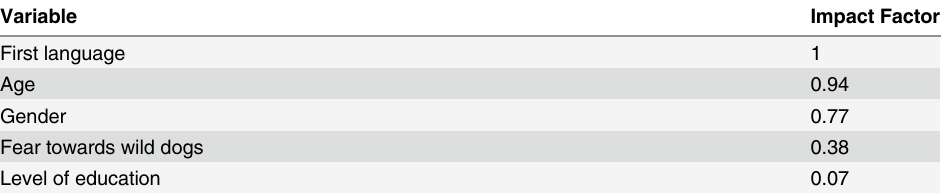
Table 3. The individual Akaike weights (impact factors) for the human demographic variables predict- ing the threat index of respondents towards wild dogs in the Great Fish River Nature